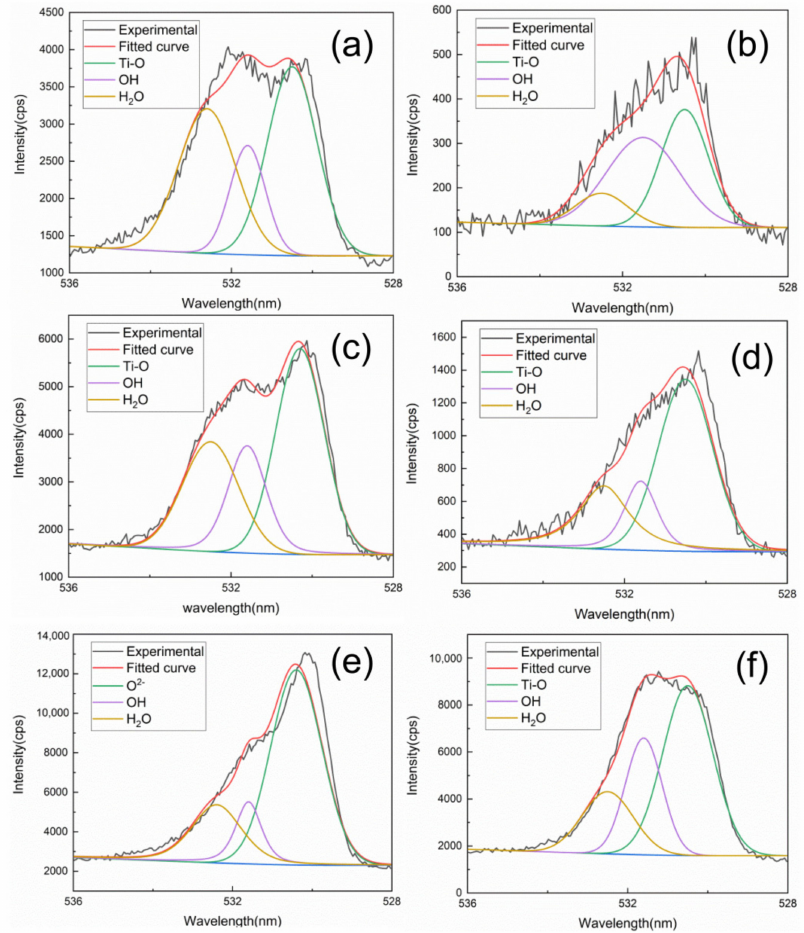
Figure 9. XPS spectrum of O 1s at different heating times: ( a ), ( c ) and ( e ) mechanical grinding at 0.5, 2 and 10 h, ( b ), ( d ) and ( f ) laser cleaning at 0.5, 2 and 10